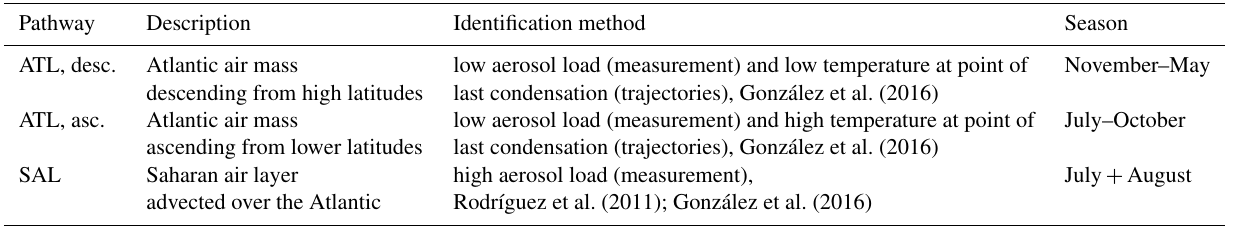
Table 3. The dominant moisture pathways to the free troposphere in the surroundings of Tenerife.